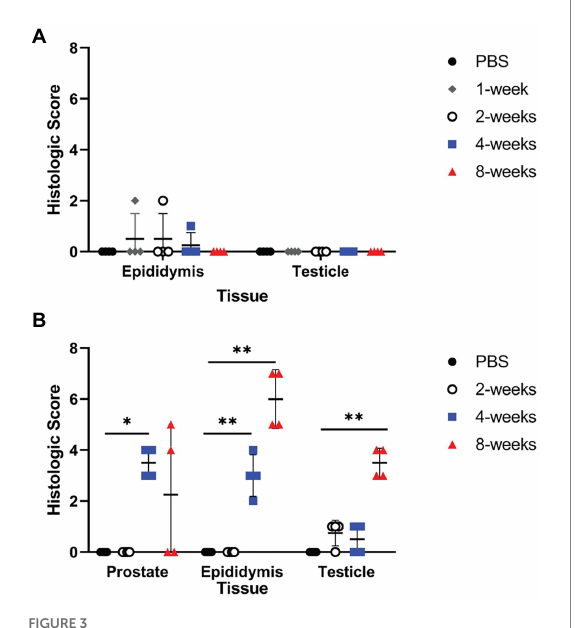
FIGURE 3 Infection resulted in significant inflammation in the epididymis and prostate of guinea pigs. Histologic changes of the testicle, epididymis, and prostate were scored for inflammation, edema, necrosis, and tissue architecture changes in the mouse (A) and guinea pig (B) . Prostate from the mouse was not available for histologic examination. Histologic scores between PBS controls and infected animals at each time point were compared using the Kruskal-Wallis test followed by Dunn’s multiple comparisons. Horizontal line indicates median. Statistical significance compared to controls * p < 0.05; ** p < necrotizing and histiocytic epididymitis with no mature spermatids in the epididymal duct which suggests spermiostasis (Figure 2B). The lack of spermatids within the epididymal duct was likely secondary to disordered spermatogenesis in the testicle.